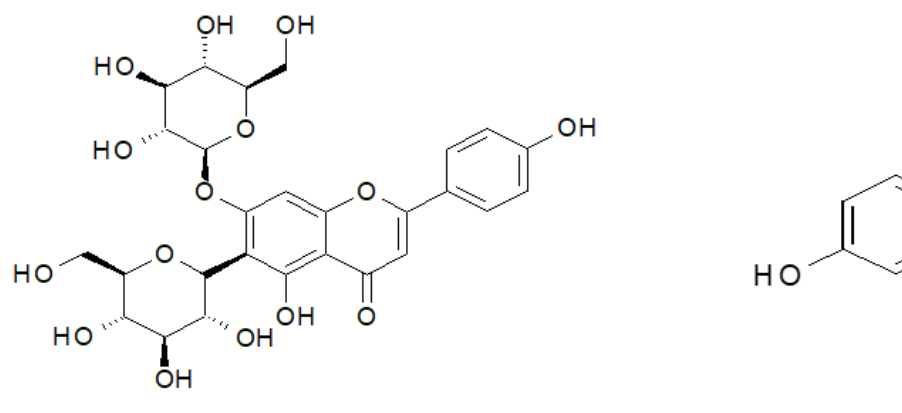
Figure 4. Structures of most represented antioxidant compound. Isovitexin 7- O -glucoside. p -coumaric acid.